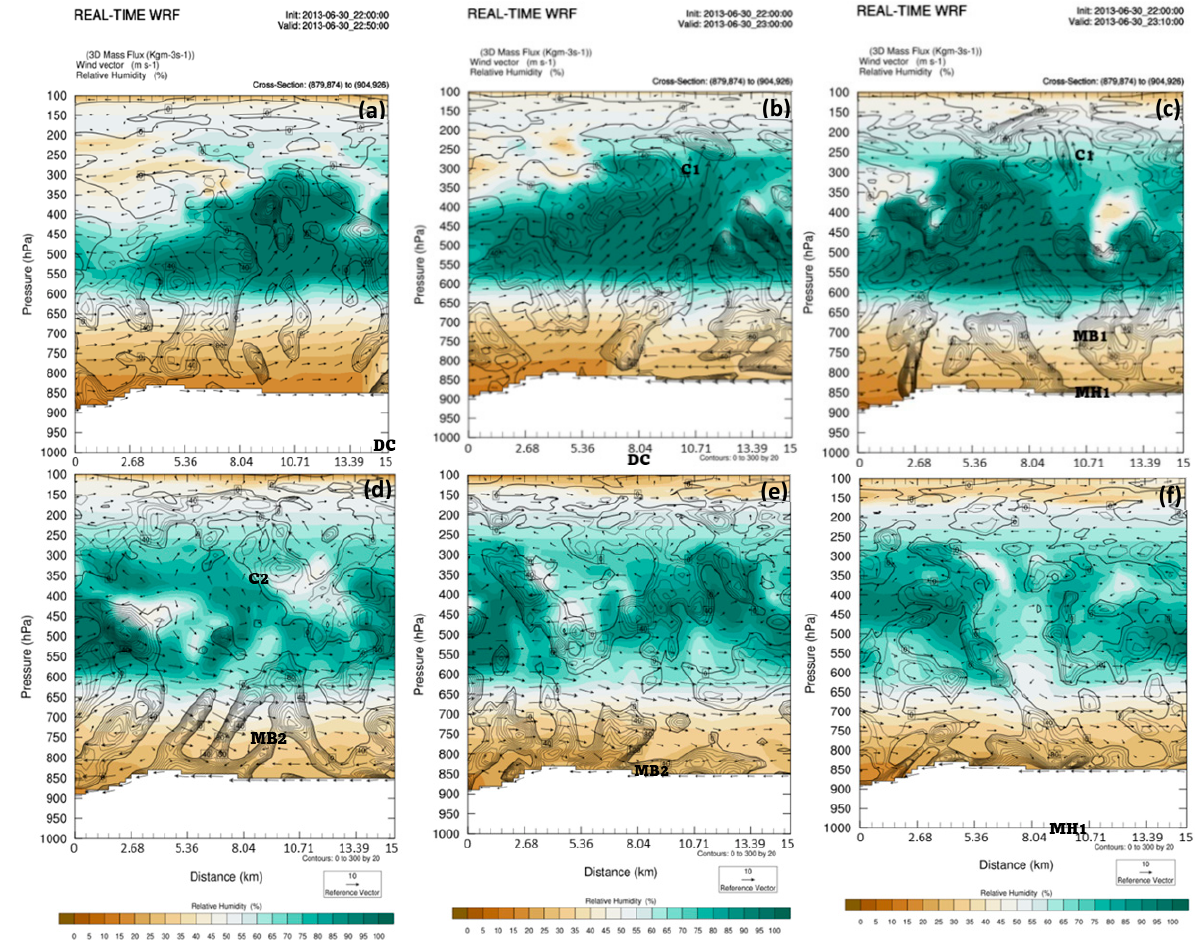
Figure 8. WRF-LES 259 m simulated vertical cross-section C-D of 3D wind vectors (ms − 1 ) within the plane of the cross-section, ( b ) relative humidity (fill > 50%), and 3D mass flux convergence (positive solid in Kgm − 3 s − 1 ) within the plane of the cross-section valid at ( a ) 22250 UTC, ( b ) 2300 UTC, ( c ) 2310 UTC, ( d ) 2320 UTC, ( e ) 2330 UTC, and ( f ) 2340 UTC 30 June 2013. DC = density current, HH = hydraulic head, FRJ = front-to-rear jet, C = convective cell, MH = meso- γ -scale